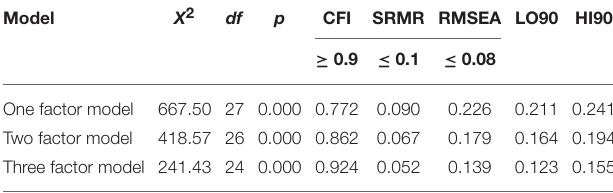
TABLE 7 | Confirmatory Factor Analyses for all models for the sample of study 2.